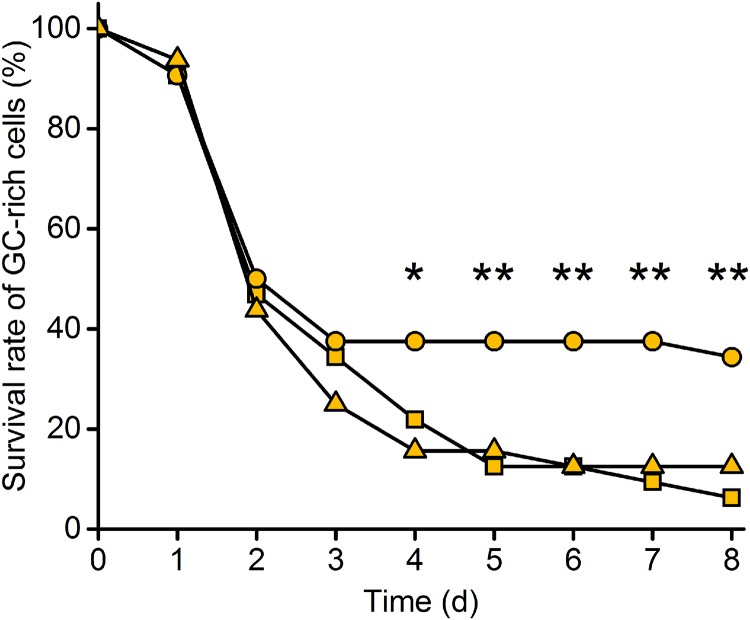
GC-supplementation partially rescues fitness of cells with GC-rich plasmids.Eight pairwise cocultures of cells harbouring AT-rich and GC-rich pJet plasmids were co-inoculated (1:1 ratio) and serially propagated on a daily basis. Strains were supplied with AT or GC deoxyribonucleosides (100 μM per nucleoside). Survival rates of GC-rich E. coli strains were calculated by scoring the number of populations, in which GC-rich strains were still present relative to the total number of populations within each treatment (n = 32). Each of the eight pairwise combination of strains was replicated four times. Treatment groups comprise the unsupplemented control (triangles), supply with AT-nucleosides (squares), and supply with GC-nucleosides (circles). Asterisks indicate survival rates that were significantly different from the unsupplemented control group. False discovery rate-corrected Wilcoxon signed ranks-test: ** P < 0.01, * P < 0.05, n = 32 per group.